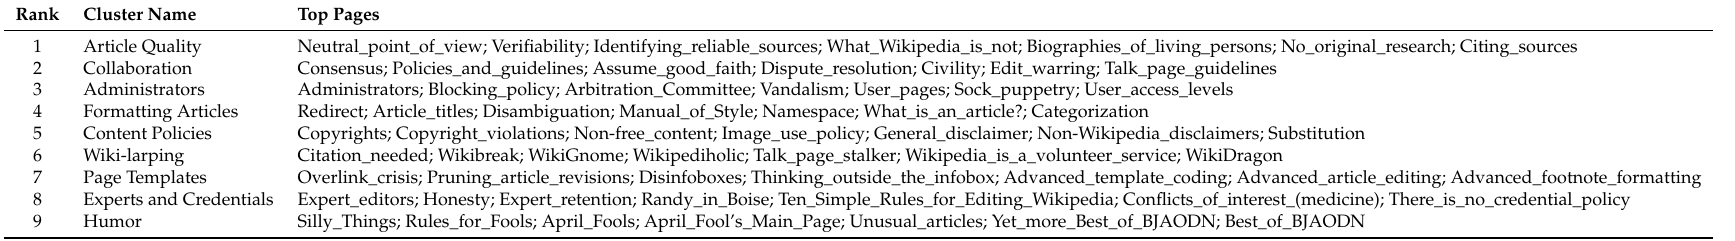
Table F.2. Top pages within each cluster, by eigenvector